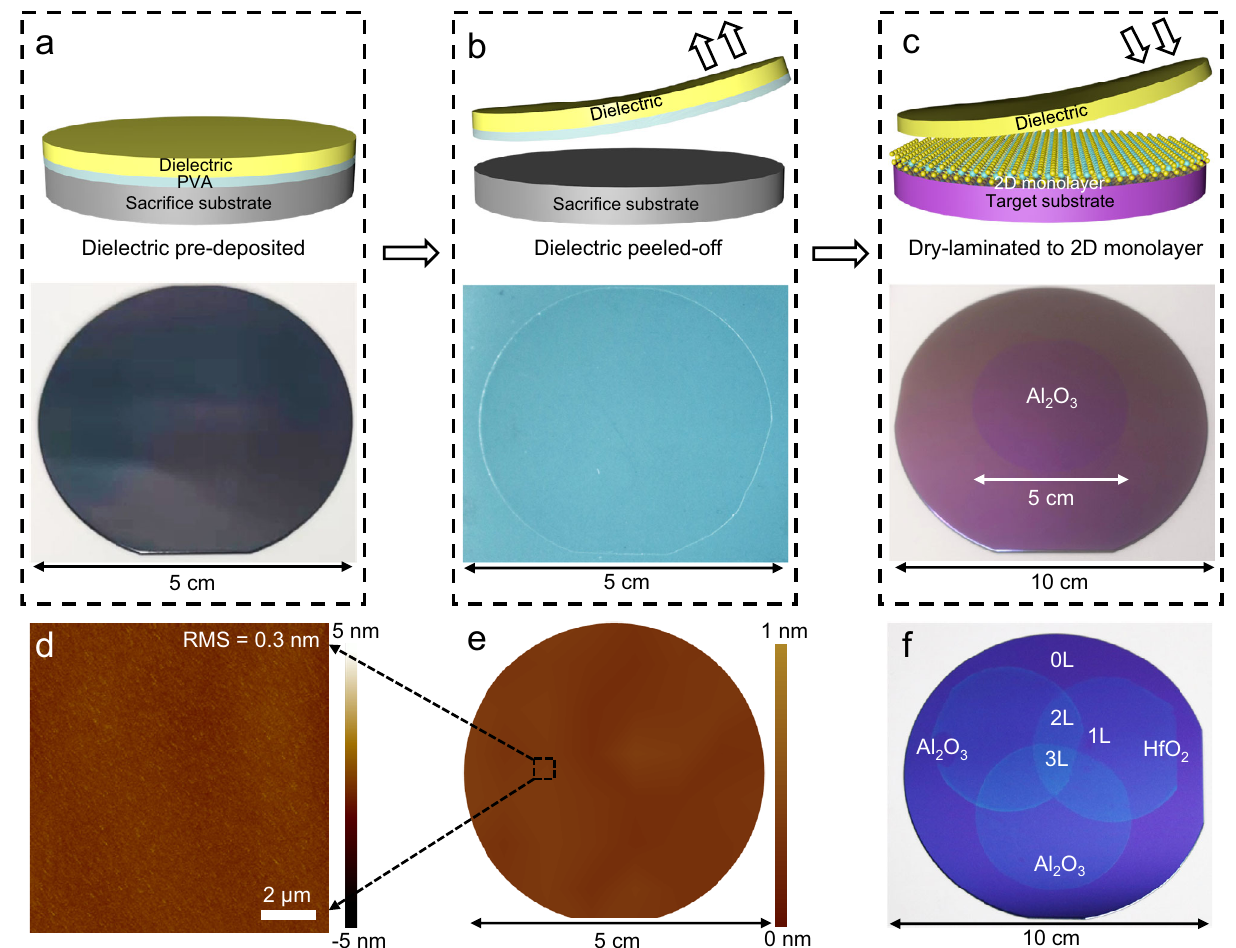
Fig. 1 | Wafer-scale high- κ dielectric layers transfer process and characteriza- tion. a – c Schematics and optical images of wafer-scale dielectric lamination pro- cess with three steps: pre-deposition on PVA sacri fi ce layer using ALD process ( a ), dielectric dry peeling-off ( b ), and dielectric lamination on top of target substrate ( c ). d AFM height measurement for the bottom side of transferred Al 2 O 3 with a